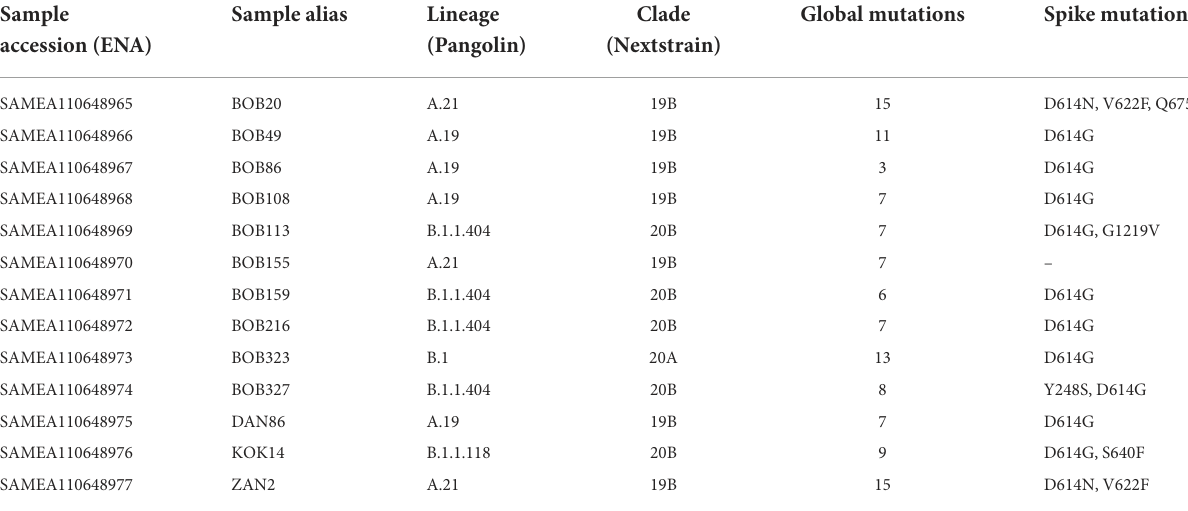
TABLE 2 Circulating lineages and clades of SARS-CoV-2 in Burkina Faso from August to November 2020.